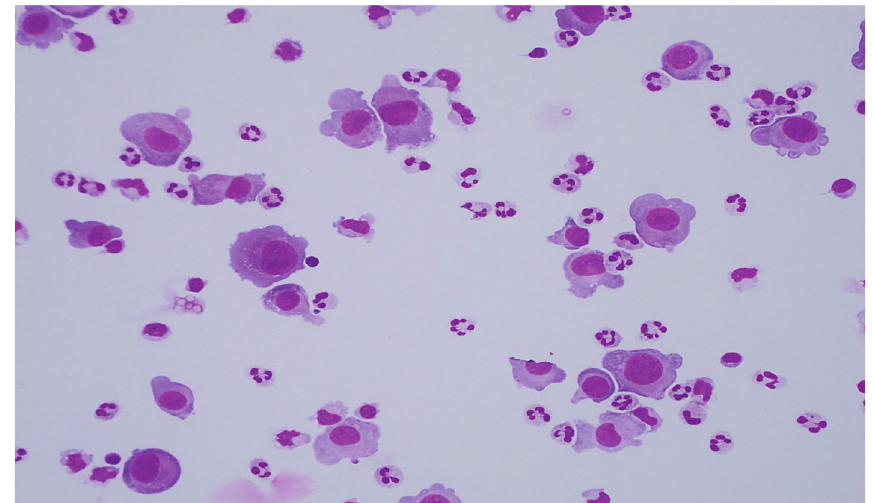
Figure 2: Cerebrospinal fluid analysis at time of isolated CNS relapse in August 2019 showing diffuse involvement by lymphoma